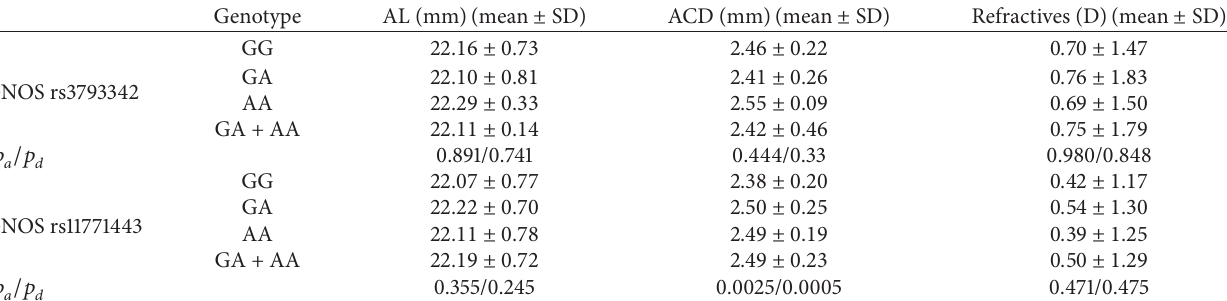
Table 5: The relationship of biometric parameters with genotypes of rs3793342, rs11771443 in PAC